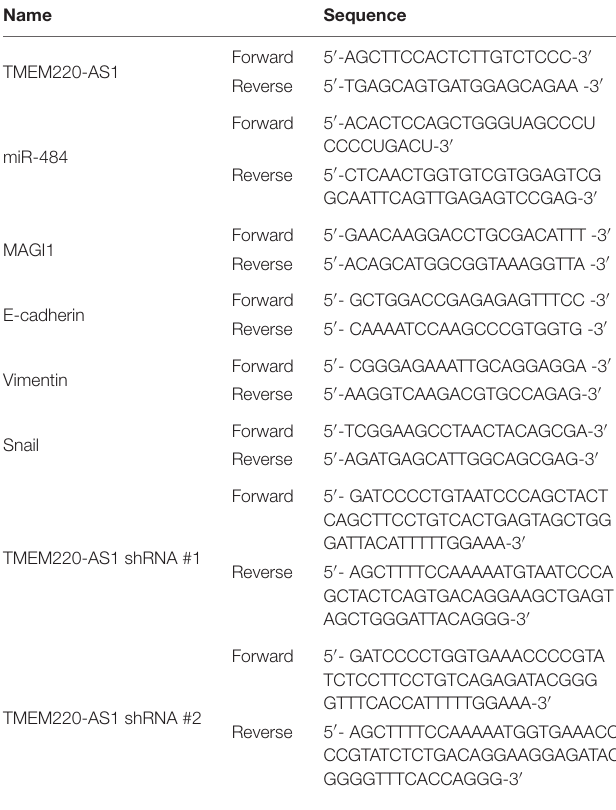
TABLE 1 | qRT-PCR or shRNAs related